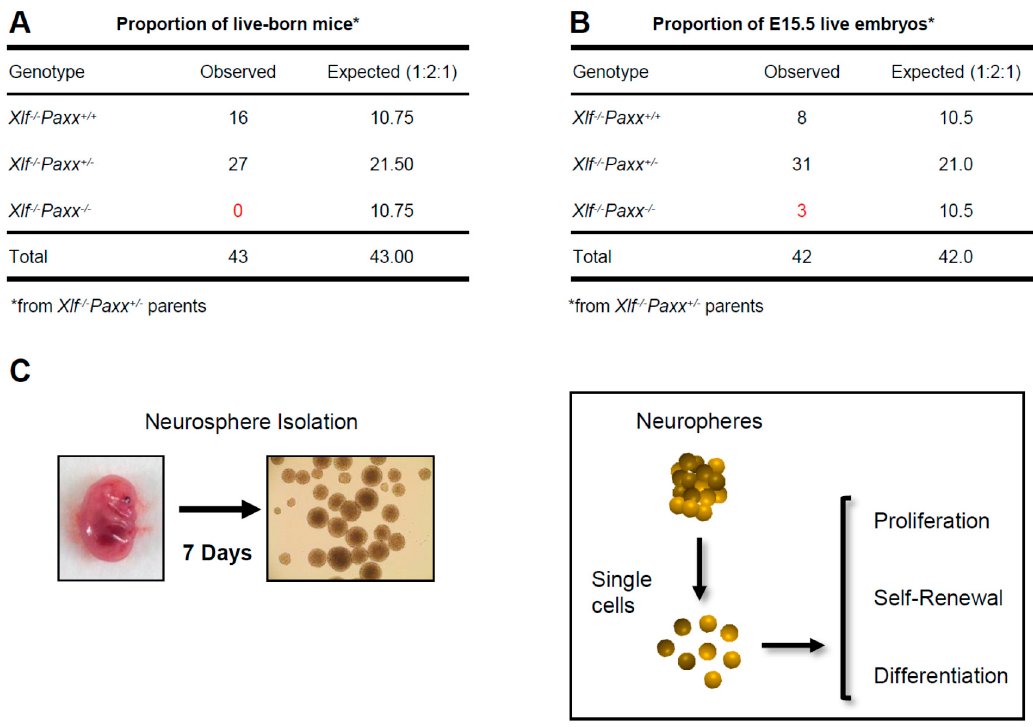
Figure 1. Workflow of the neurosphere-based experiments. ( A ) Synthetic lethality between Xlf and Paxx in mice. The proportion of live-born mice from Xlf − / − Paxx +/ − parents. No Xlf − / − Paxx − / − double knockout live-born mice were observed out of 43 pups analyzed. ( B ) Fifteen-day-old Xlf − / − Paxx − / − mouse embryos are alive. The proportion of genotypes from Xlf − / − Paxx +/ − parents. Three E15.5 Xlf − / − Paxx − / − embryos were detected out of 42 analyzed. ( C ) Schematic view of the experiment. Embryos were collected at day E15.5 and neural stem and progenitor cells (NSPCs) were isolated from the embryonic brains. Single NSPCs formed neurospheres in cell culture. Every seventh day, the neurospheres were treated with trypsin to obtain NSPCs used to perform the proliferation, self-renewal and differentiation experiments. Detailed statistical analysis for NSPC proliferation, Figure 2B. WT vs. Xlf − /